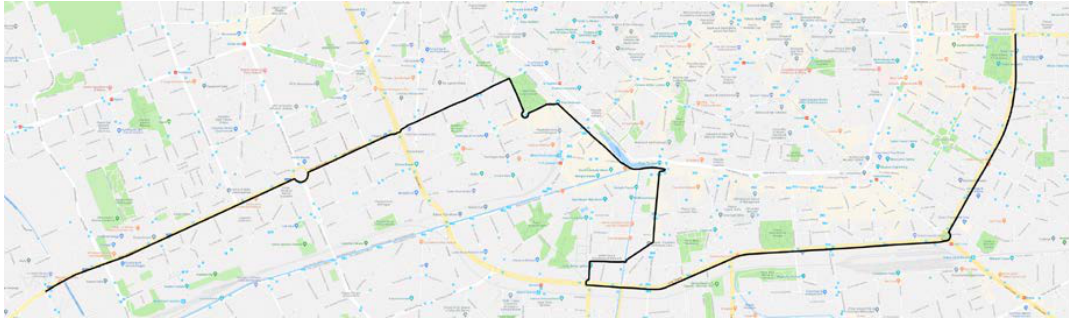
Figure 5. Path selected for the first set of experiments (QGIS elaboration of Google Maps). Each driver was equipped and monitored by means of the previously presented wearable devices (T-shirt/top with electrodes, GSR bracelet, and video camera on the head or on the dashboard), and was instructed about the path to follow. The tests were carried out with other people on board to activate the instruments and to use the connected applications.